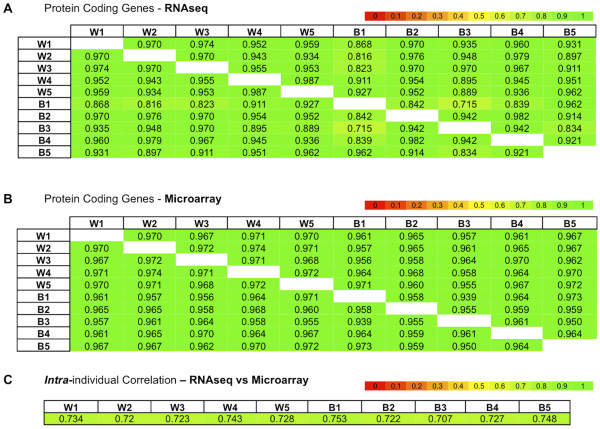
Inter- and intra-individual correlations. A) Heatmap of the inter-individual correlation of all mRNA transcripts (RNA-seq). B) Heatmap of the inter-individual correlation of all mRNA transcripts (microarray). C) Heatmap of the intra-individual correlation of all mRNA transcripts (RNA-seq vs microarray). The sample IDs are labeled with a W (White) or B (Black).